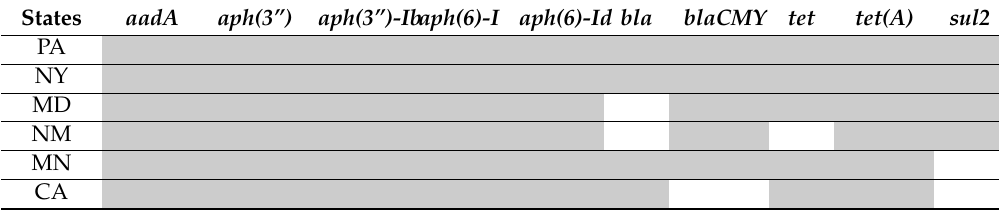
Note: the shaded areas indicate involvement of the genes in the corresponding